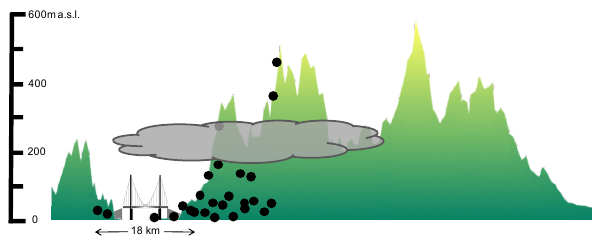
Figure 2. North-facing schematic of Fig. 1 indicating the vertical distribution of BEACO 2 N node sites (circles) over the topography of Oakland, CA. The cloud marks the altitude and thickness of a typical marine fog layer; the bridge delineates the height of the San Francisco–Oakland Bay Bridge. Horizontal placement of nodes has been skewed for visual